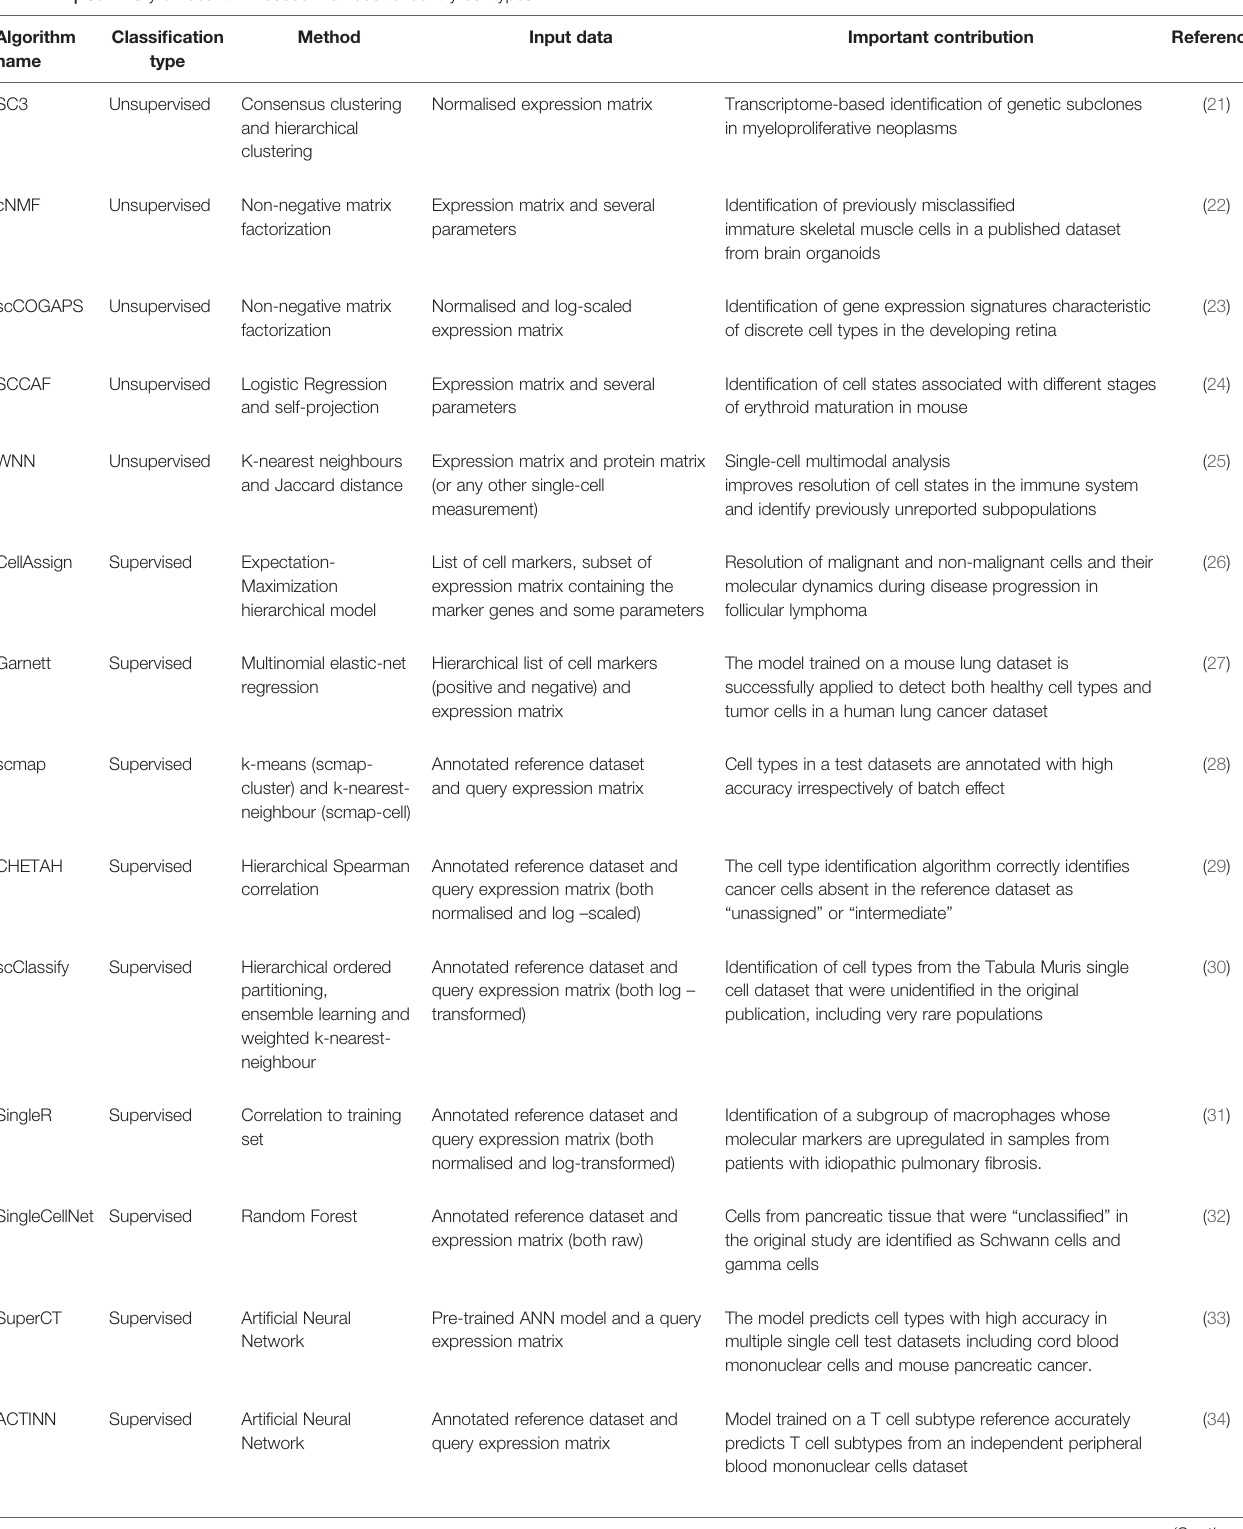
TABLE 1 | Summary of recent ML-based methods to identify cell types. Algorithm